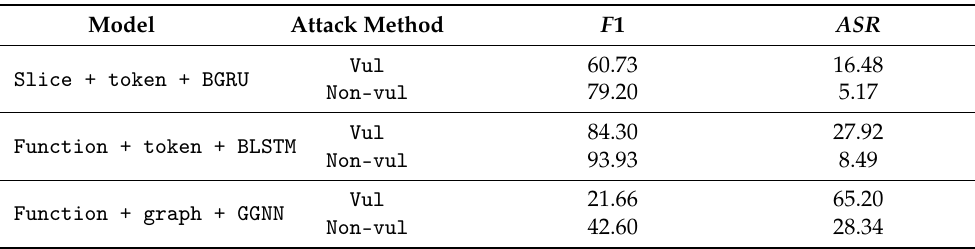
Table 5. Comparing the impact of vulnerability-related and non-vulnerability-related lines on adversarial example generation (unit: %)